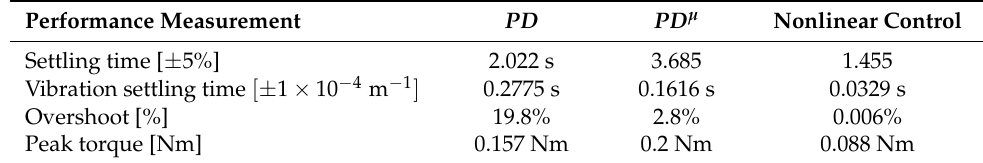
Table 3. Performance measurement and comparison between PD, PD µ and nonlinear controller.